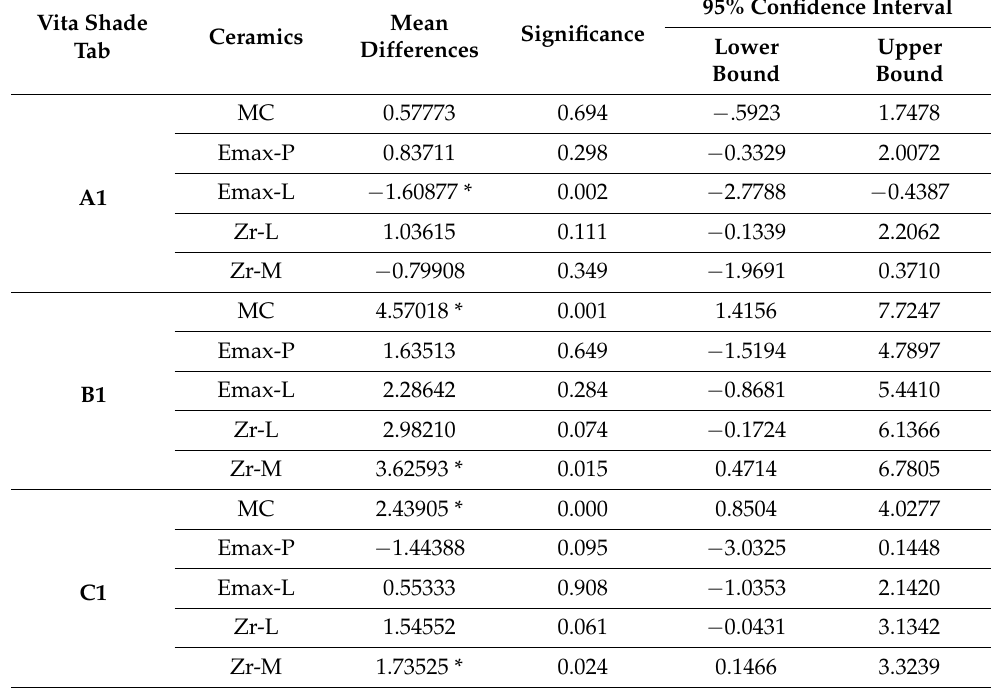
Table 6. Mean differences and multiple comparisons of the translucency parameter (TP) values with the TP of vita shade guide